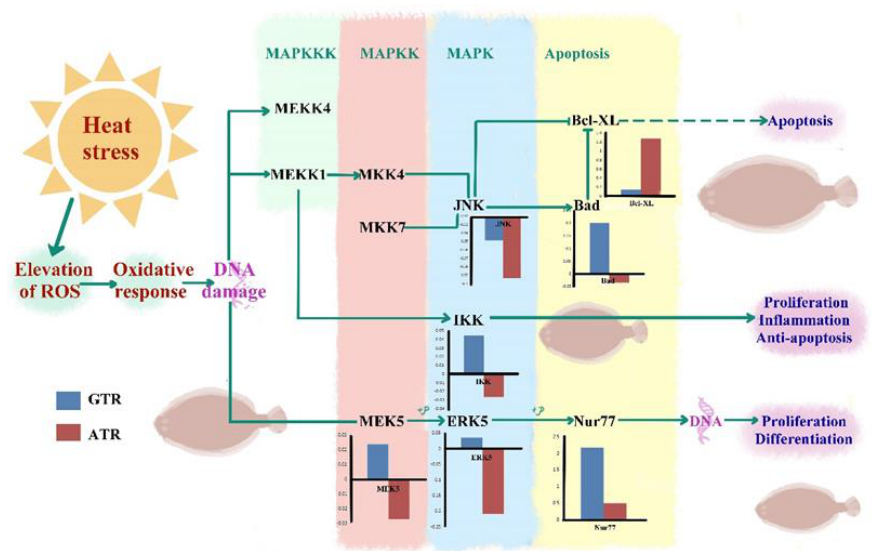
Figure 6. The response of the mitogen-activated protein kinase signaling (MAPK) pathway after two kinds of heat stress. Note: The blue bar represents the GTR while the red bar represents ATR; the up-regulated genes are above the line while the down-regulated genes are below the line.